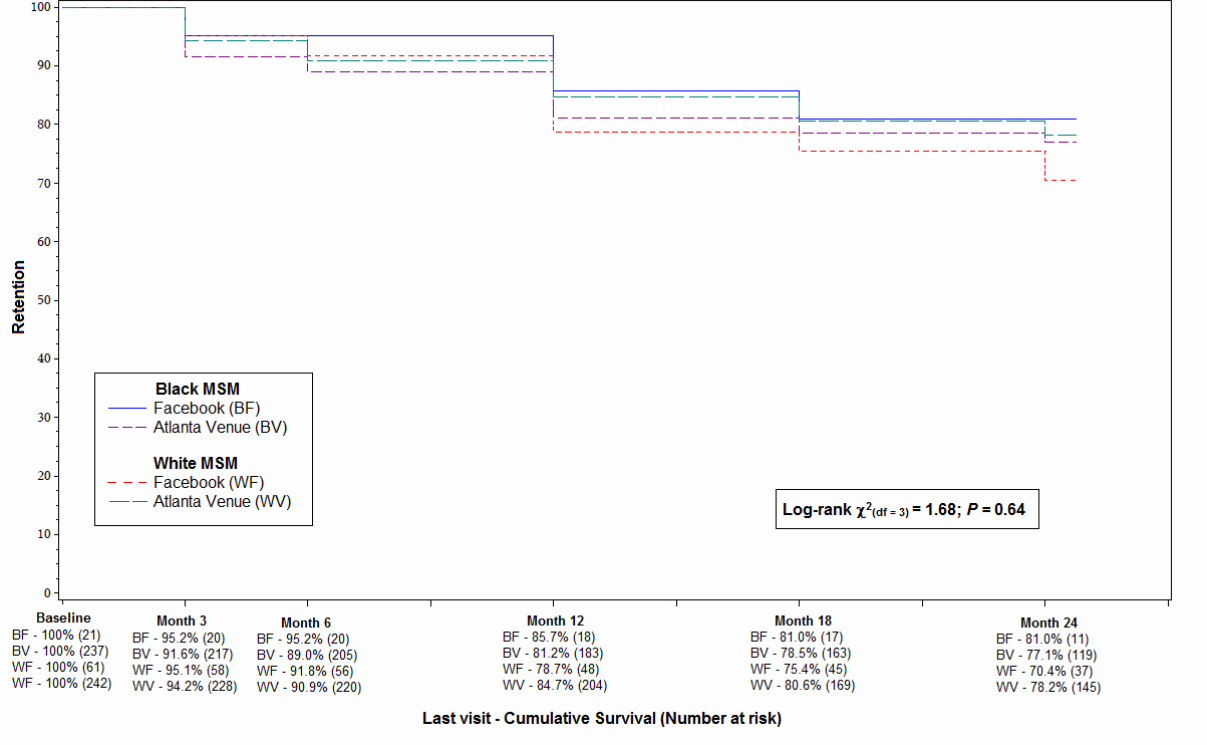
Figure 1. Study retention by recruitment type (Facebook vs Atlanta Venues) and race, InvolveMENt, Atlanta,